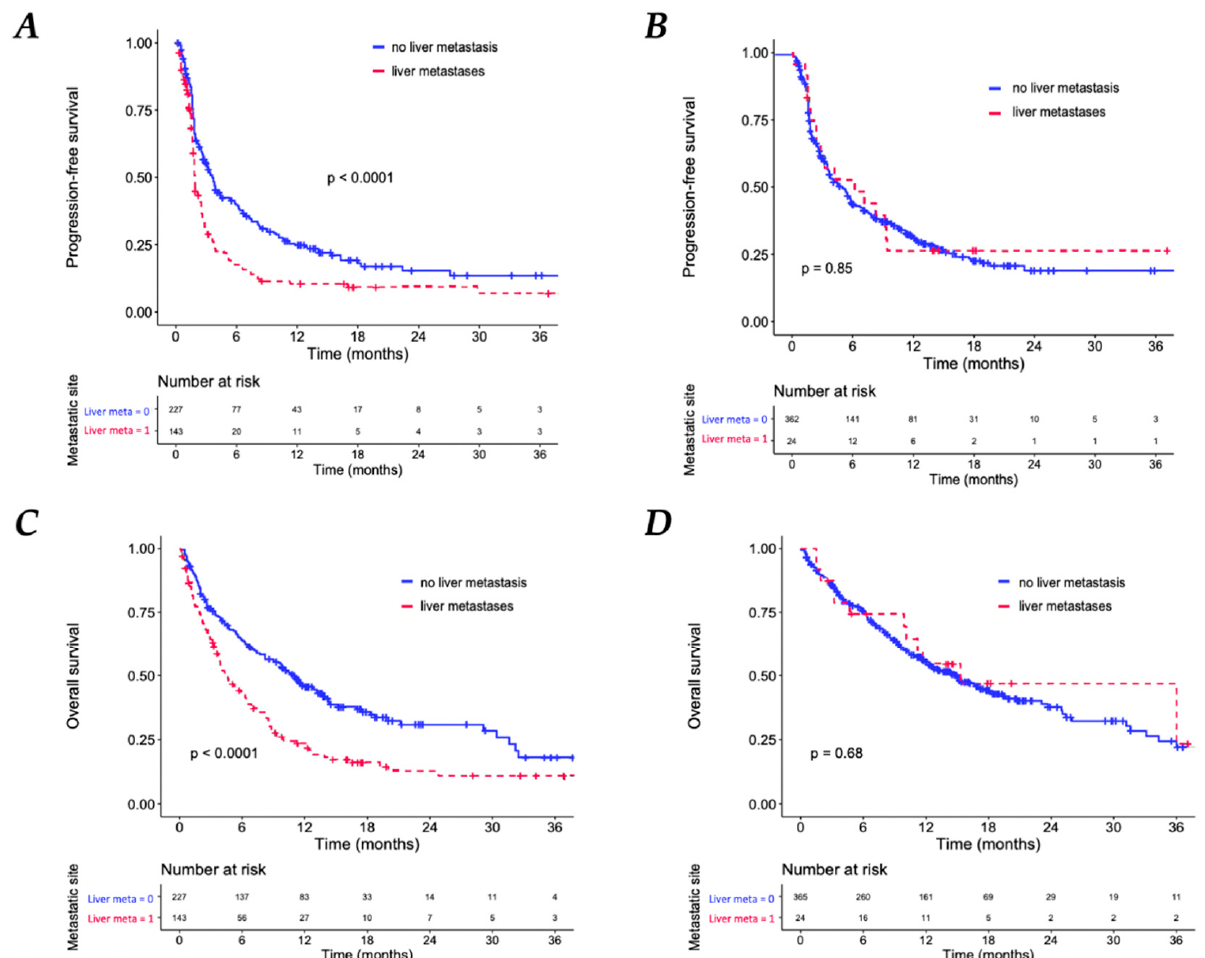
Figure 4. Kaplan–Meier Analyses. Progression-free survival (PFS) according to the presence of liver metastases in patients with multiple sites of metastasis, ( A ) and in patients with only one MS ( B ). Overall survival (OS) according to the presence of liver metastases in patients with multiple sites of metastasis ( C ) and in patients with only one MS ( D ).